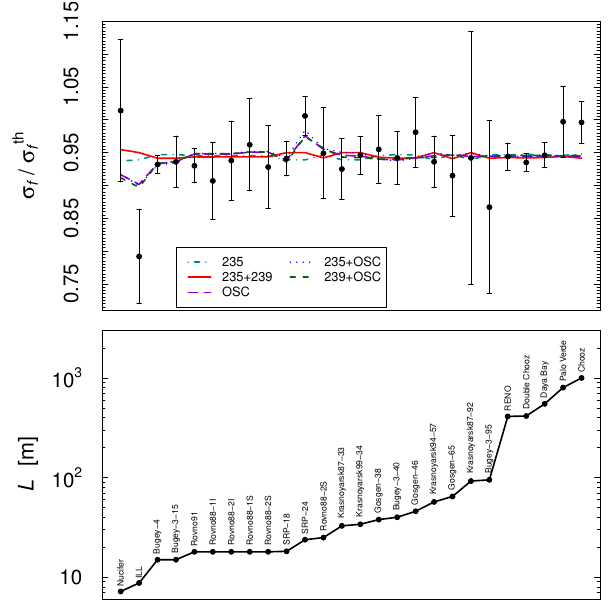
Figure 7 . The top panels show the (cid:12)ts of the reactor rates in table 1 of ref. [12]. The data are ordered by increasing values of the source-detector distance L , shown in the bottom panel. The error bars show to the experimental uncertainties.